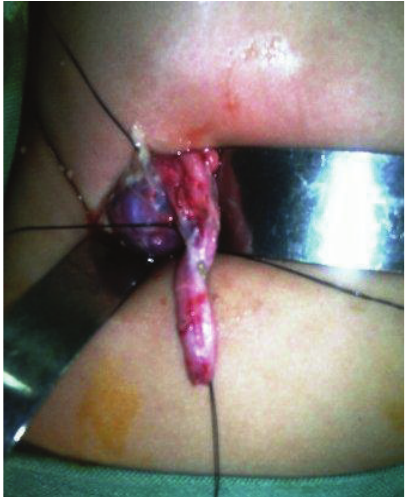
Figure 6: Photograph showing ureteric stricture opened longitudi- nally with no evident